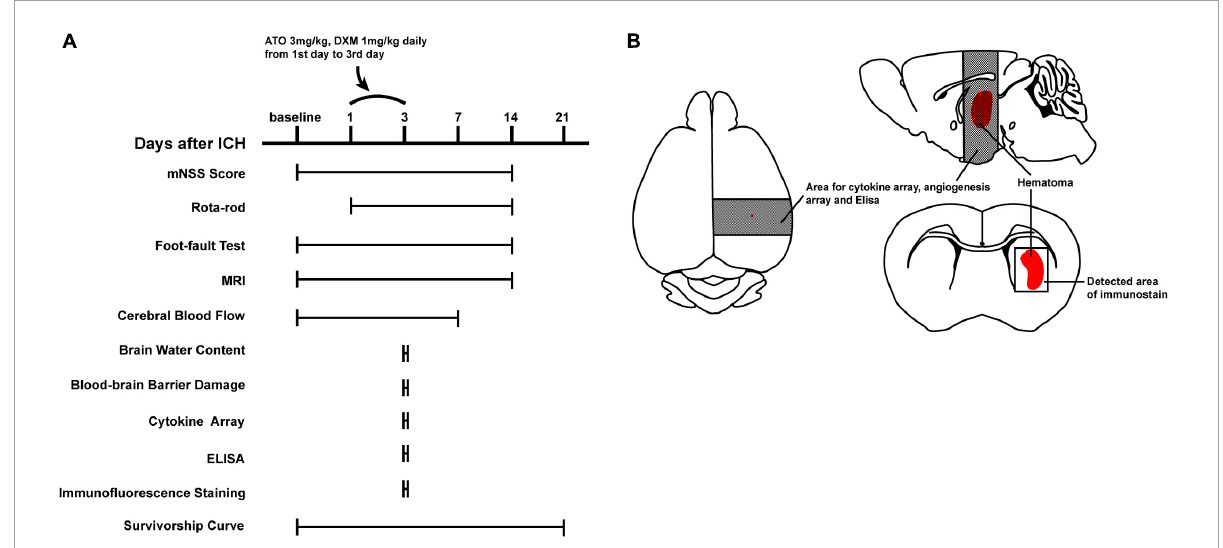
FIGURE1 Experimental design. (A) Schematic of the experimental timeline for functional and pathological assessments. (B) Schematic of the brain of ICH mice. Dark shaded areas of brain tissue were used for cytokine arrays, angiogenesis arrays, and ELISA. Lightly shaded areas were used for the immunofluorescence